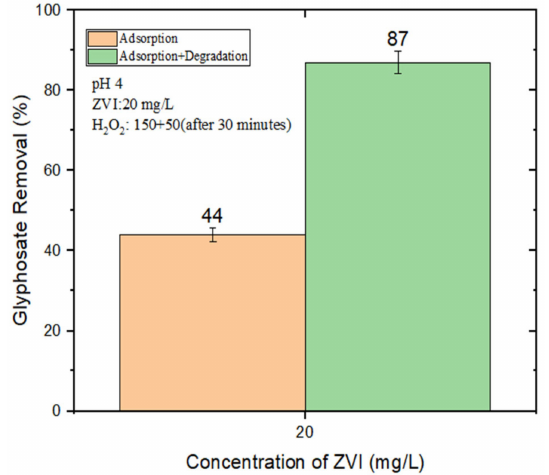
Figure 3. GLY removal (%) by nZVI (20 mg/L) and, where applicable (“Adsorption + Degradation”), H 2 O 2 (150 µ M at t = 0 + 50 µ M at t = 30 min) at pH